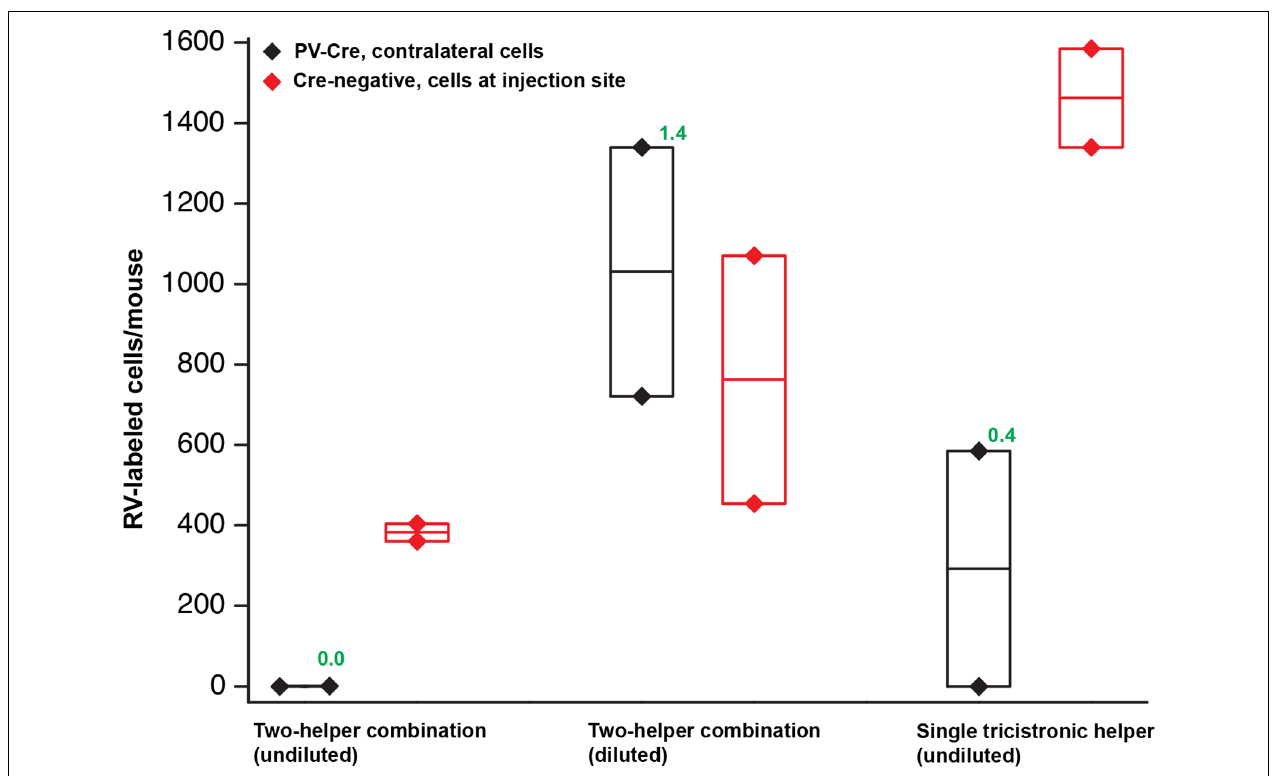
FIGURE 4 | Quantification of results in PV-Cre and Cre-negative mice: a pilot study with helper viruses either undiluted or diluted to titers used in previous work. Black depicts numbers of neurons labeled by RV in the contralateral cortex (in every other 50 µ m section) in PV-Cre mice; red depicts numbers of RV-labeled neurons in the vicinity of the injection site, i.e., in ipsilateral cortex (in every other 50 µ m section) in Cre-negative mice for all conditions. Diamonds represent cell counts from individual mice; the middle lines in the boxes represent the average count for each condition. Numbers in green represent the ratio of contralateral neurons in Cre+ mice to ipsilateral neurons in Cre − mice. “Diluted” here means diluted to the titers of other batches used previously in our laboratory; see main text for details. Excessive concentrations of helper viruses gave very poor results. Source numbers are provided in Supplementary Table S1